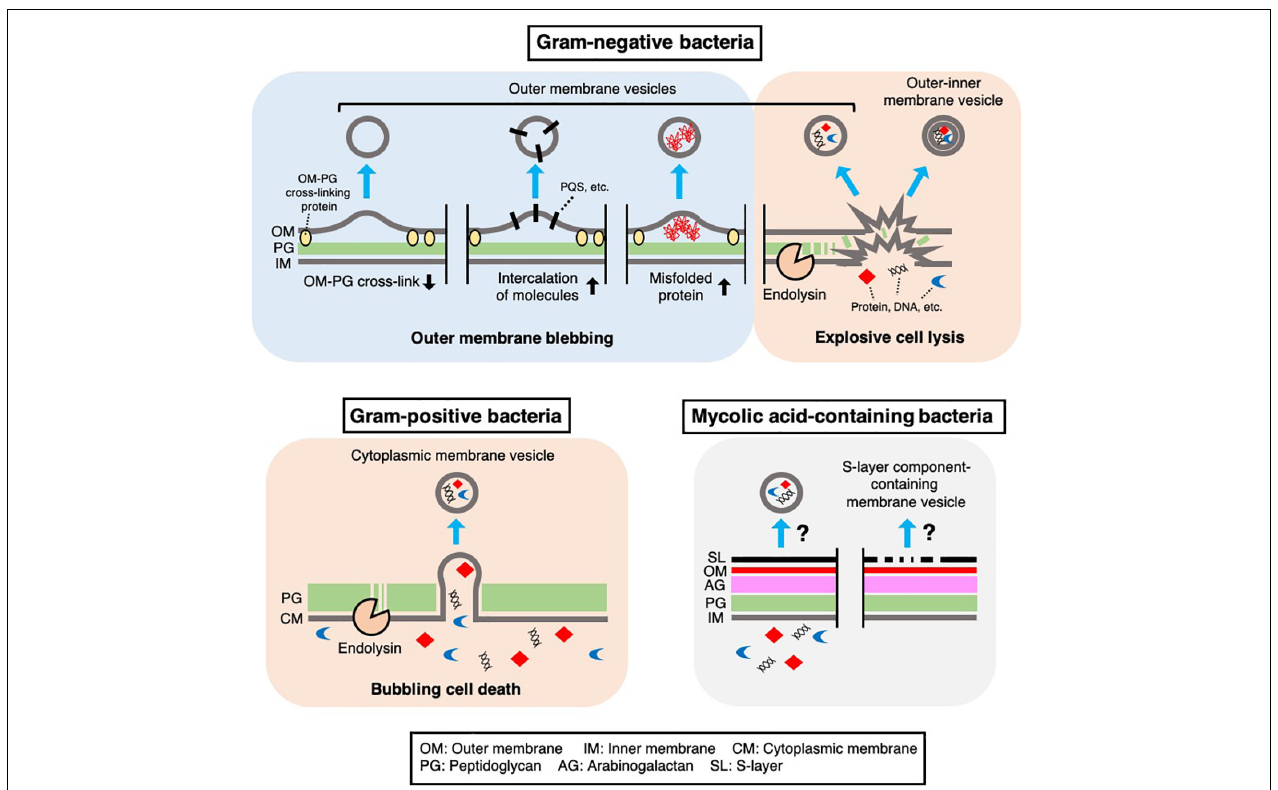
FIGURE 1 | Mechanisms of MV biogenesis. Several mechanisms underlying MV formation in bacteria have been proposed. In Gram-negative bacteria, outer membrane vesicles and outer-inner membrane vesicles are produced through outer membrane blebbing or explosive cell lysis. Outer membrane blebbing is induced by structural changes in the cell envelope, such as a decrease in outer membrane-peptidoglycan cross-linking proteins, intercalation of molecules [such as Pseudomonas Quinolone Signal (PQS)] in the membrane, or the accumulation of misfolded proteins at specific regions of the cell envelope. Explosive cell lysis is triggered by phage-derived endolysin, which degrades the cell wall. In Gram-positive bacteria, cytoplasmic membrane vesicles are produced through bubbling cell death, in which phage-derived endolysin degrades the cell wall and the cytoplasmic membrane protrudes through the resulting holes in the peptidoglycan. In mycolic acid-containing bacteria, the mechanism of MV formation remains unknown, although there is evidence that these bacteria produce MVs containing inner membrane lipids or cell envelope associated-proteins such as S-layer component